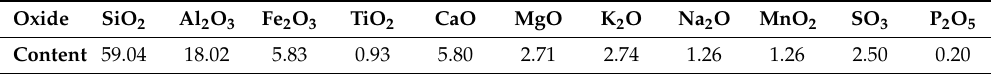
Table 1. Proximate and ultimate analysis of the test coal (%). Table 2. Ash composition of lignite (wt %).